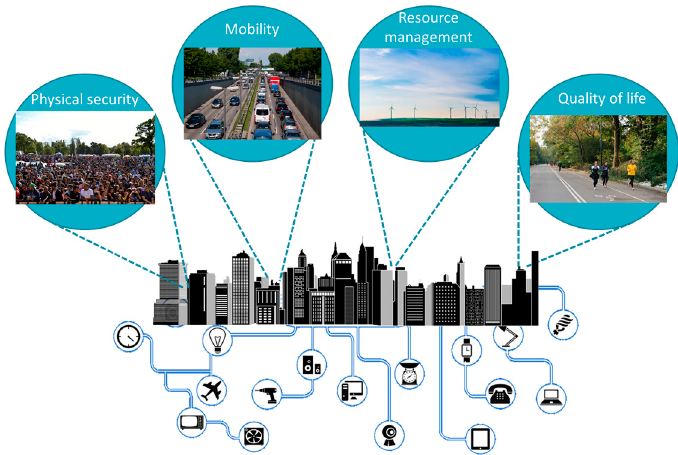
Figure 1. Figure 1. A graphic representation of the vision within the Internet of Things for Urban Innovation (iNUIT) program with main services based on a network of connected objects (Internet of Things Things paradigm).